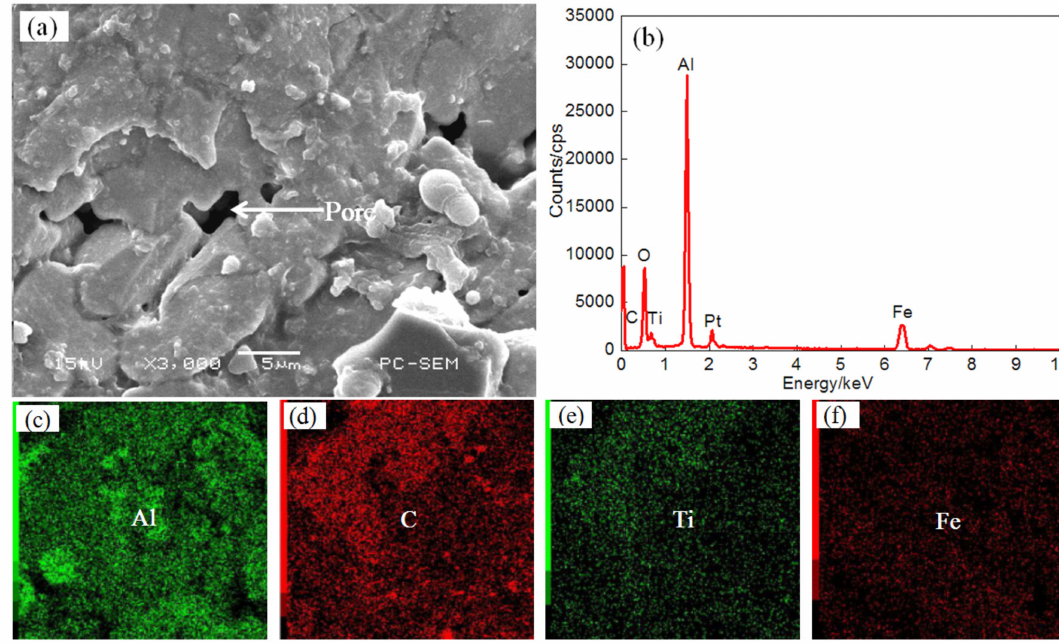
Figure 7. The surface SEM images ( a ) and EDS analysis result ( b ) and element content of Plane scan (( c ) Al content ( d ) C content ( e ) Ti content ( f ) Fe content ) of Coating